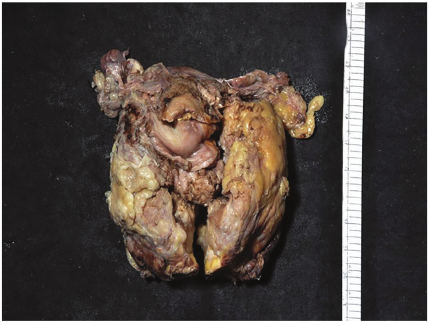
Figure 2: Resected prostatectomy specimen showing large prostatic mass with variegated appearance with infiltration of capsule and bilateral seminal